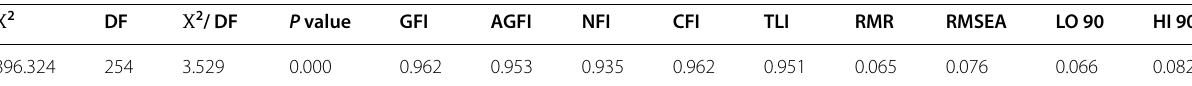
Table 5 Model fit